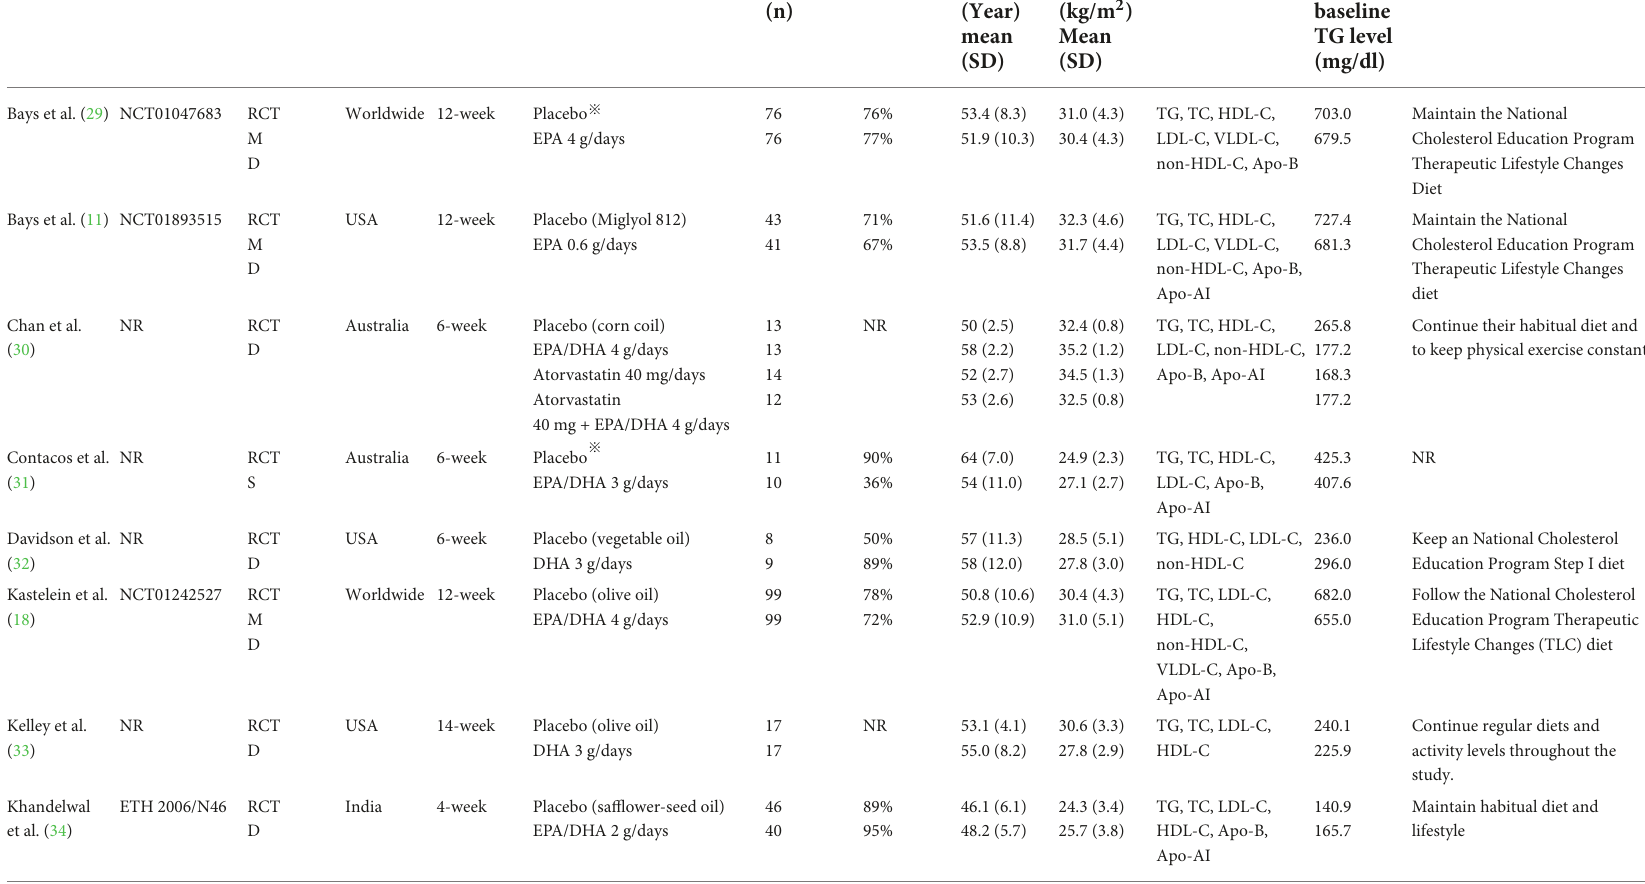
TABLE 1 Characteristics of included